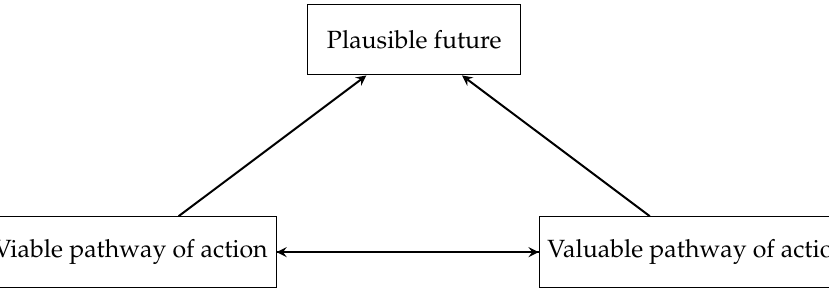
Figure 1: Constructing plausible